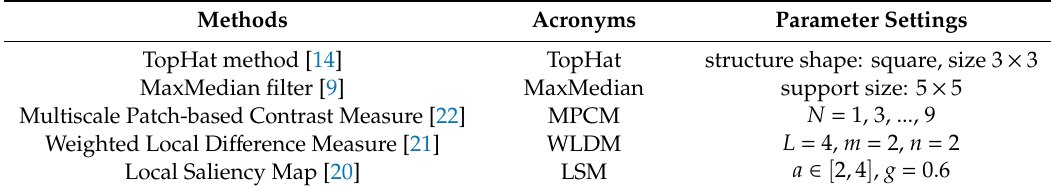
Table 4. The detailed parameter settings for the saliency and filtering based methods.